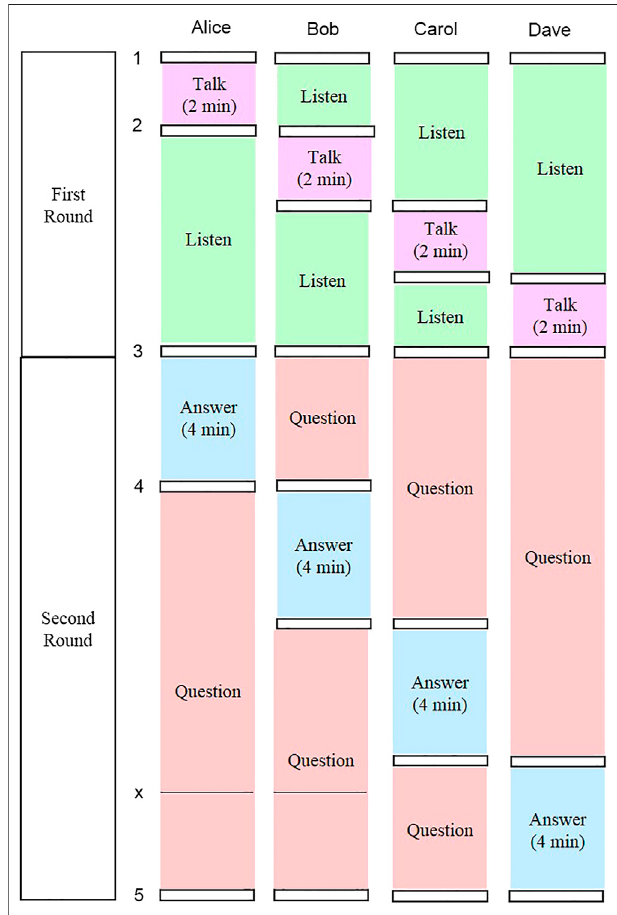
FIGURE4| Ablockdiagramofthemoderatedconversationphaseinthe PICMOR program.